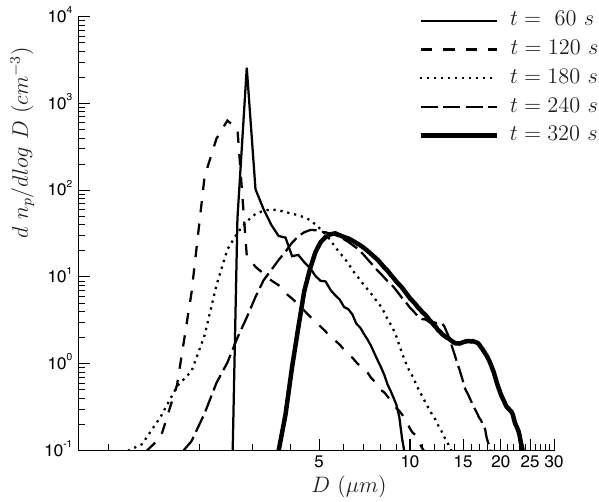
Fig. 12. Evolution of the distribution of ice particle diameter during the vortex and early dissipation regimes (run V D